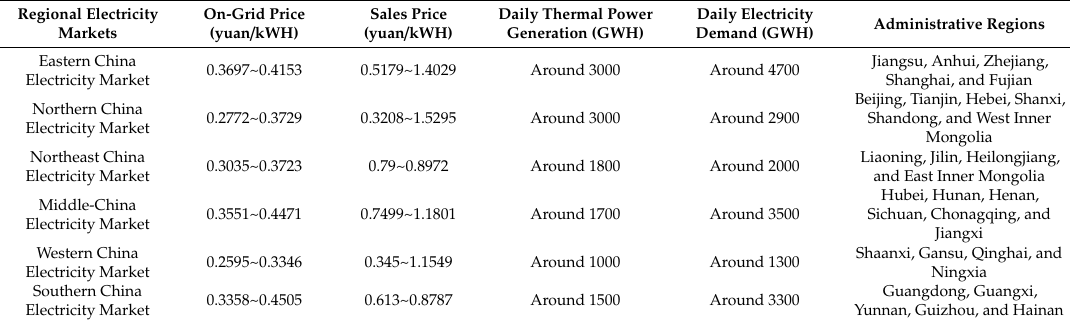
Table 9. Actual situation of main regional electricity markets.